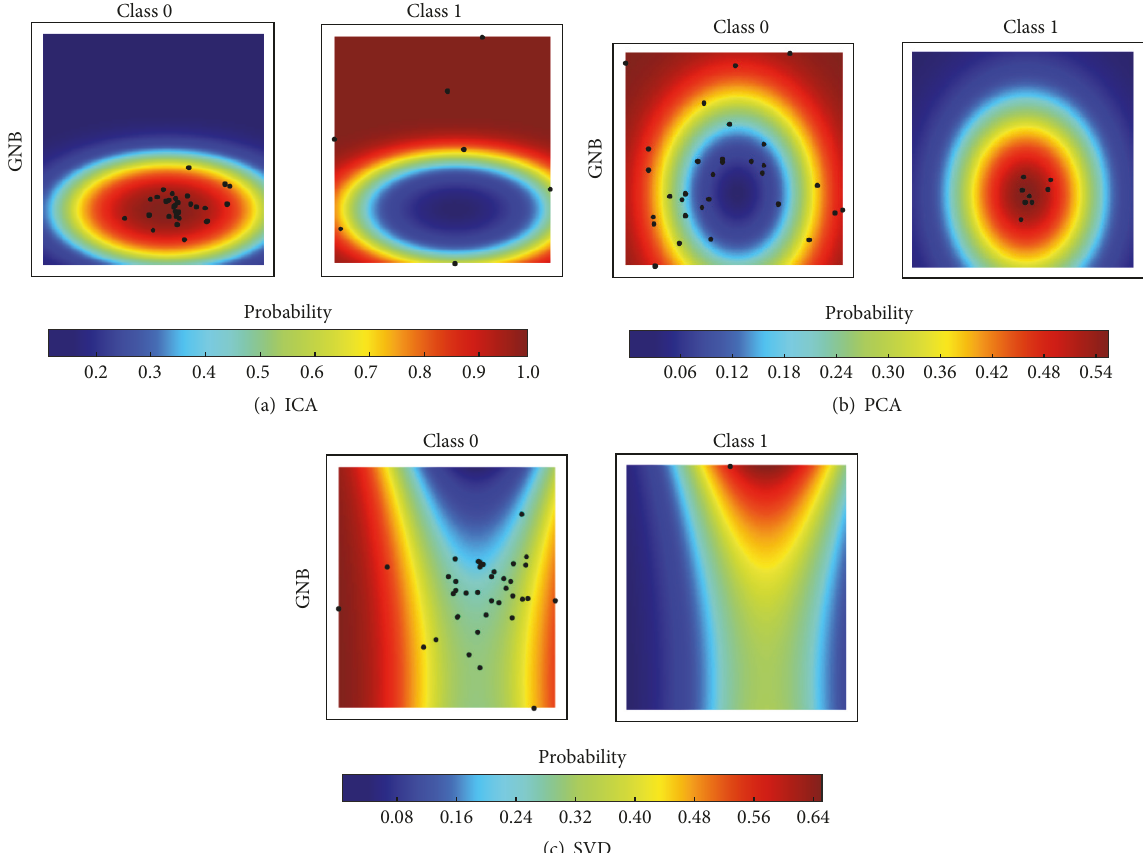
Figure 17: Contour plots of probability surface for classification using the Gaussian Naive-Bayes for ICA, PCA, and SVD data reduction techniques.